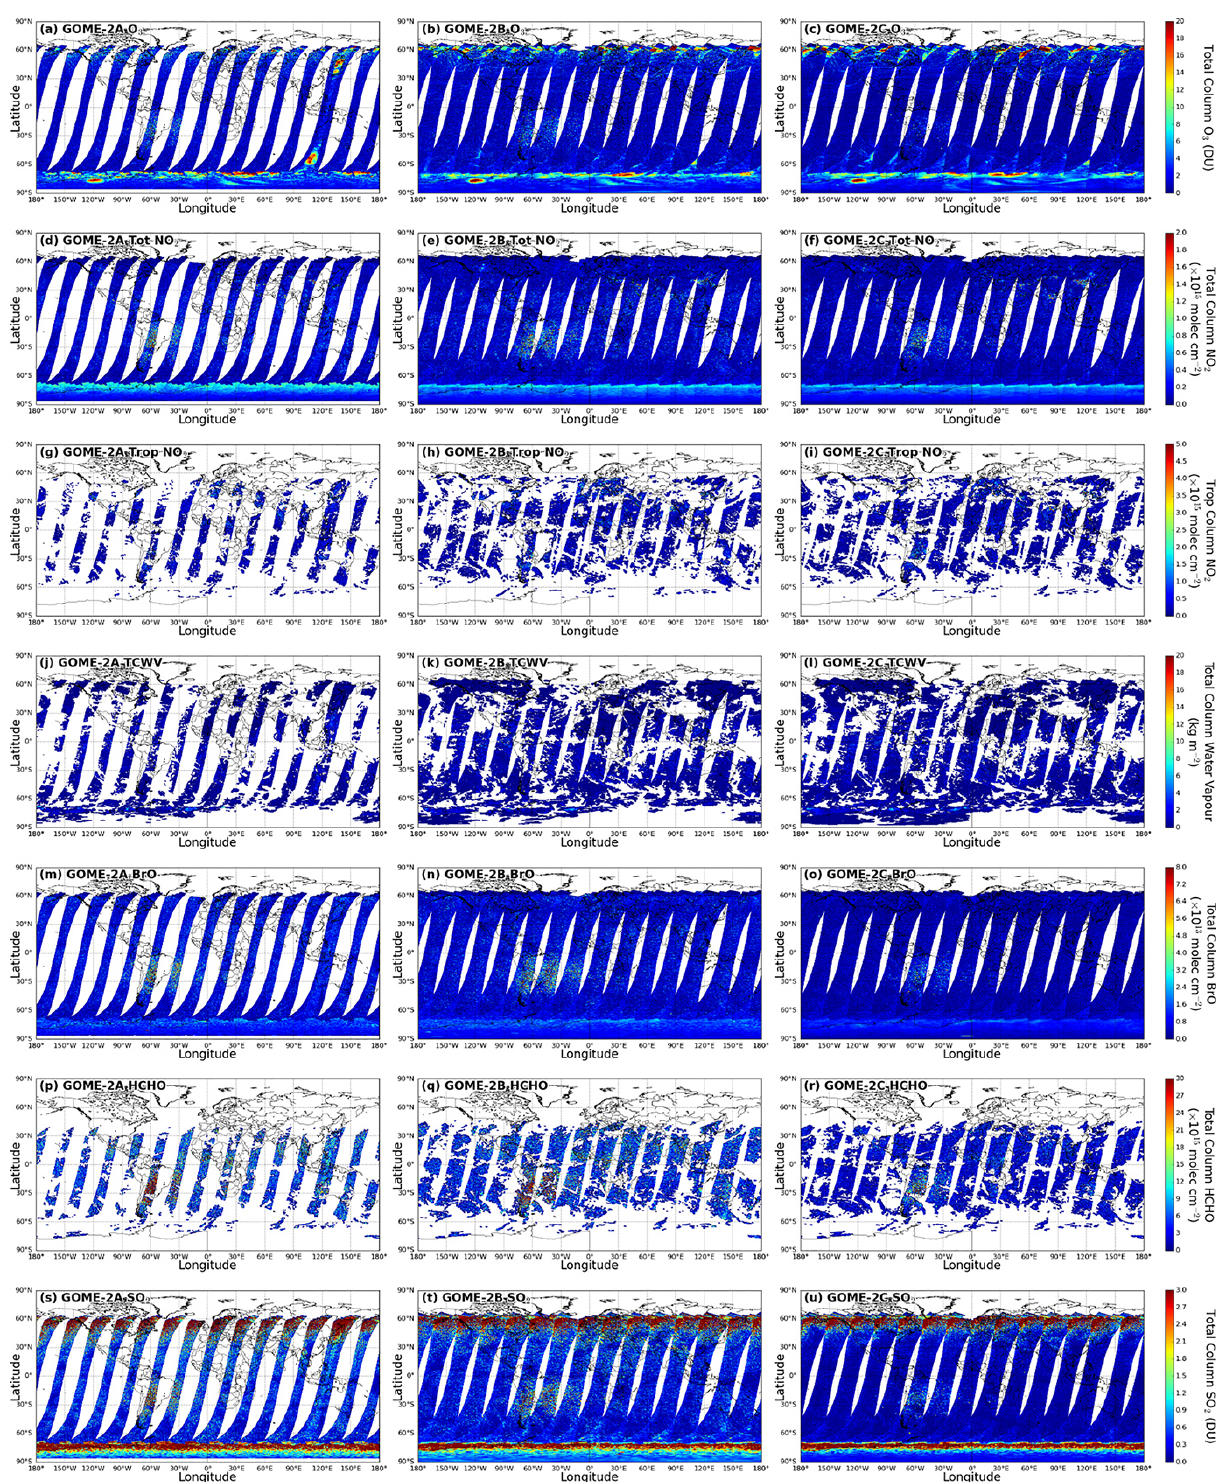
Figure 8. Derived standard deviation in the daily level-3 product of GOME-2A (first column), GOME-2B (second column), and GOME-2C (third column) for 15 January 2020. Standard deviation of total column O 3 (first row), total column NO 2 (second row), tropospheric column NO 2 (third row), total column water vapour (fourth row), total column BrO (fifth row), total column HCHO (sixth row), and total column SO 2 (seventh row) are shown.